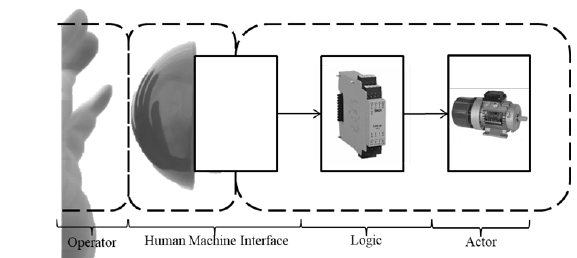
Figure 1. Extended block diagram of sample complementary protective